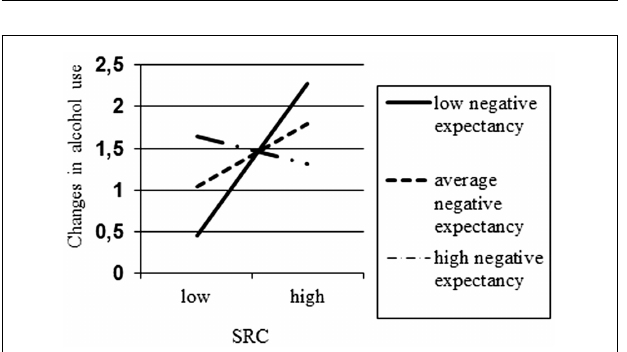
FIGURE 1 | Interaction between IAT and positive expectancies on changes in alcohol use .